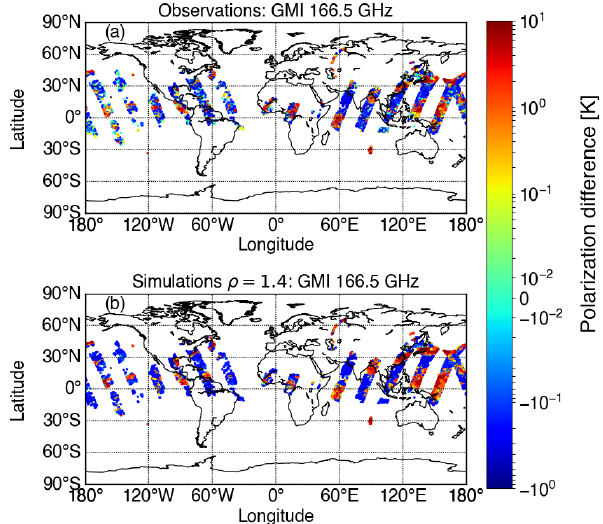
Figure A1. Performance of the screening method at an exam- ple scene measured by GMI on 13 July 2019 at a frequency of 166.5GHz. Polarization difference, i.e., brightness temperature dif- ferences between the vertical and horizontal polarization (PD = T BV − T BH ), due to oriented ice hydrometeors as (a) observed (PD o ) by GMI and (b) simulated (PD b ) for a polarization ratio ( ρ ) of